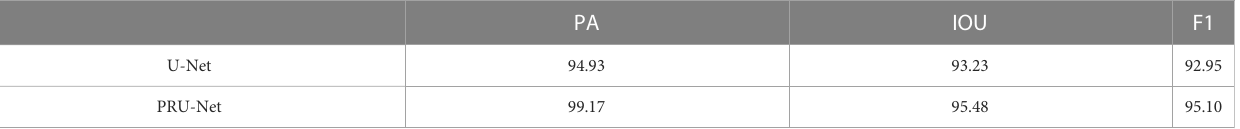
TABLE 1 Comparison of evaluation parameters before and after